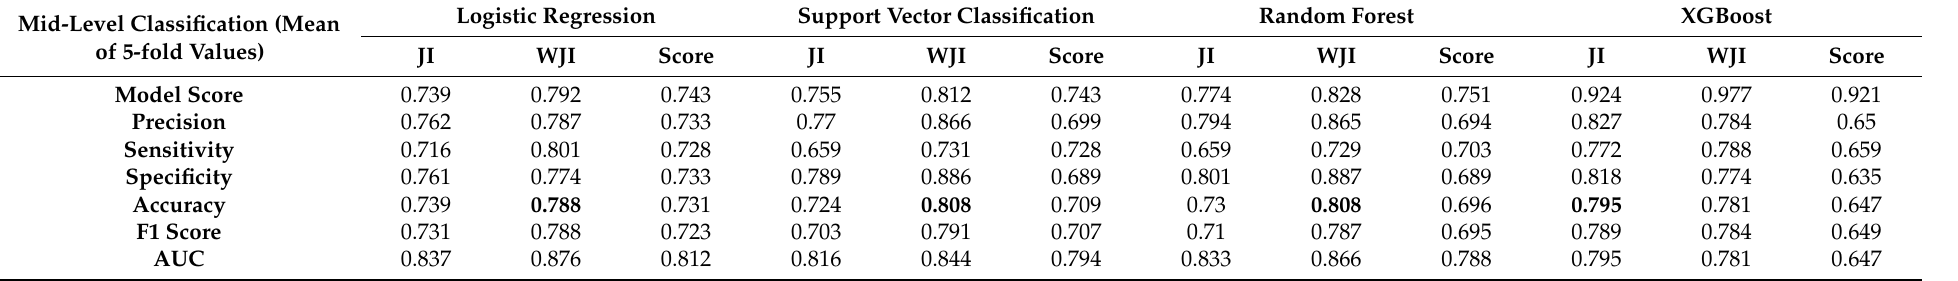
Table 8. Training and verification results of ALS_EG , ALS_CG and ALS_SELECT_FEA (mid-level